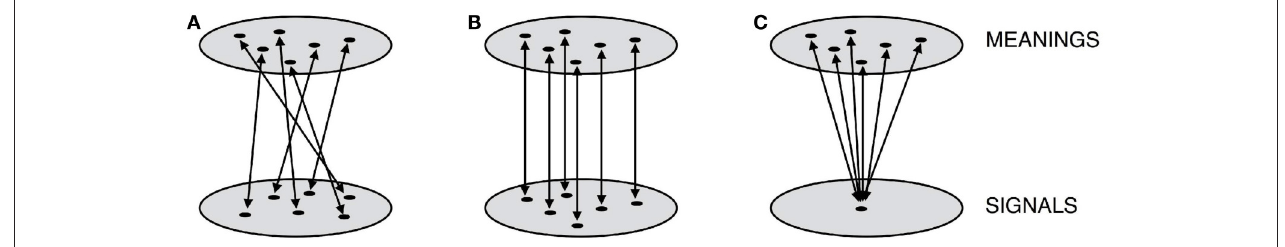
FIGURE 3 | A simplified geometric sketch of possible mappings between two domains, for example meanings and signals. These mappings can be unstructured, random and incompressible (A) , or highly structured and compressible (B) . An individual attempting to learn the latter could use similarity structure in one domain to predict what the appropriate generalization should be for unseen points. A further possibility is a degenerate mapping, which is the simplest and most compressible of all (C) .